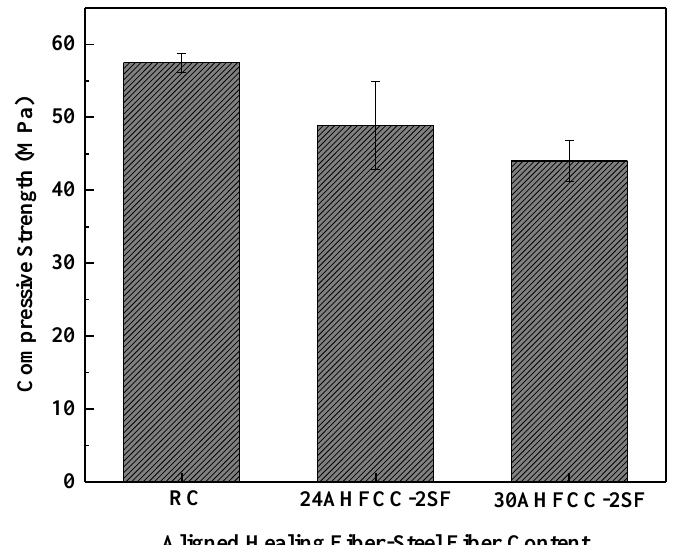
Figure 12. Healing fiber effect analysis on a cementitious